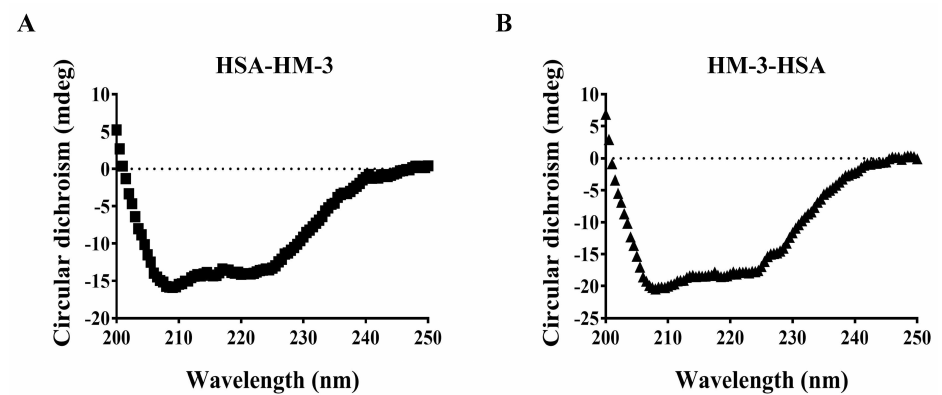
Figure 4. Far UV spectroscopy of HSA-HM-3 ( A ) and HM-3-HSA ( B ). The secondary structure of fusion proteins was analyzed by far-UV CD spectroscopy (200–250 nm). Bandwidth: 1 nm; scanning speed: 200 nm/min; D.I.T.: 0.5 sec; data pitch: 0.5 nm; and temperature: 25 ◦ C.